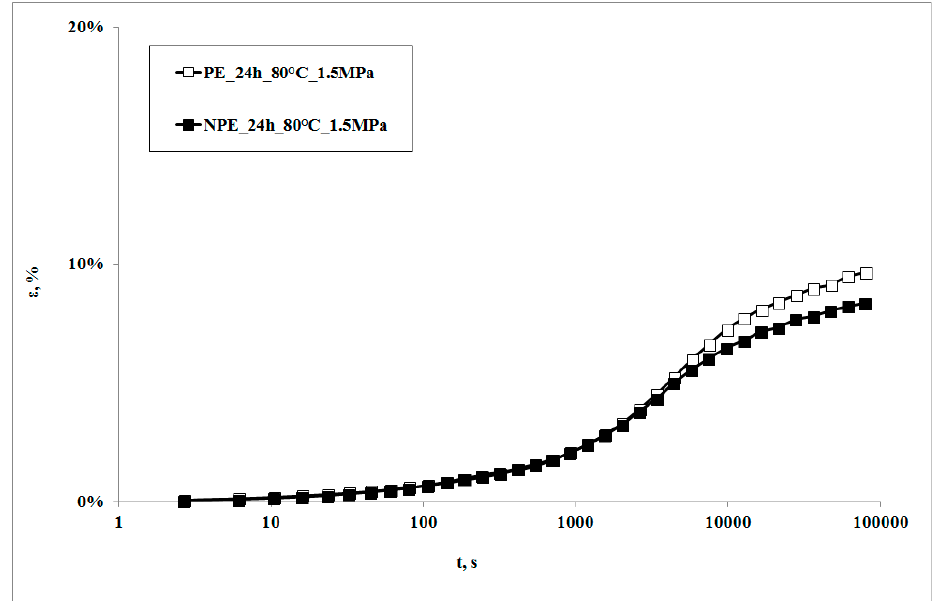
Figure 1. Creep curves at T = 80 °C.